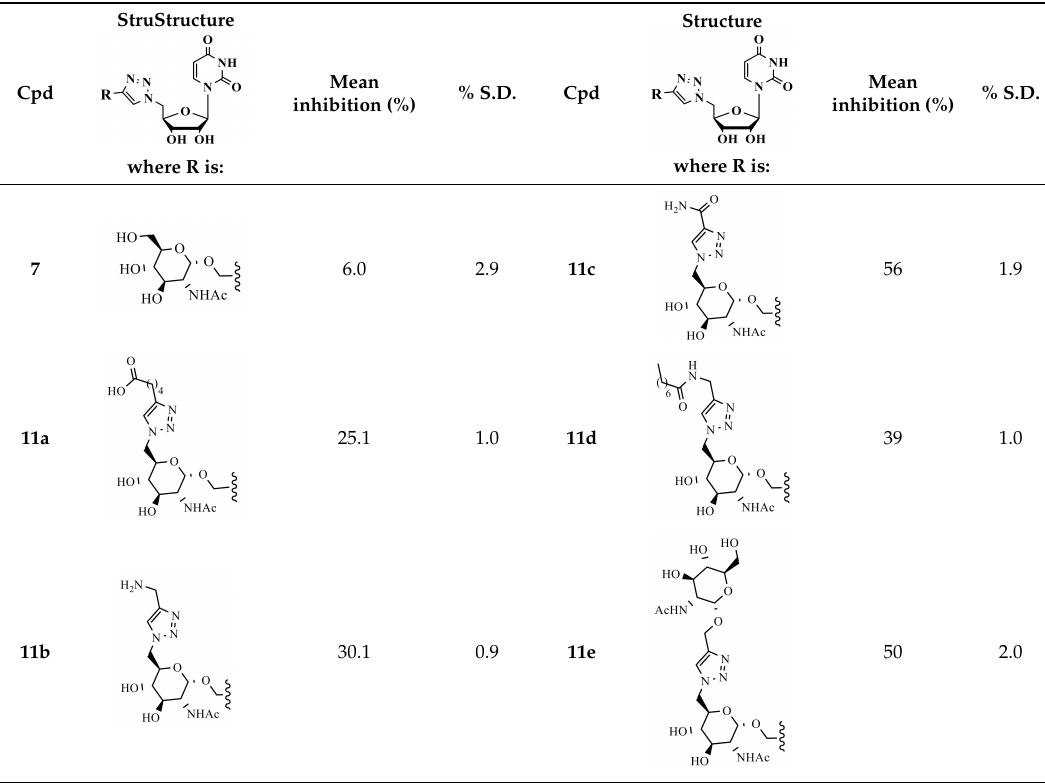
Table 2. Results of the inhibition of one-pot assay containing Mtb MurA-F enzymes by glucosamine derivatives 7 and 11a – e at 100 µ M.